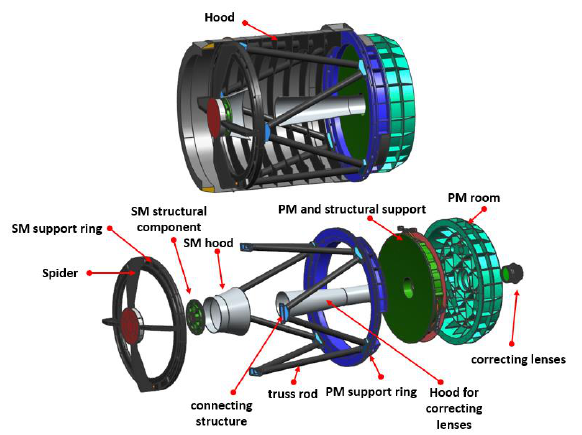
Figure 10 Machinery exploded figure of telescope The large-aperture mirror surface error performance is the key to static design. Finite element model has been analyzed for the mirror surface shape error in the optical axis horizontal state and the optical axis vertical state, and it shows that the mirror shape error achieves a perfornance value shown in Figure 11.